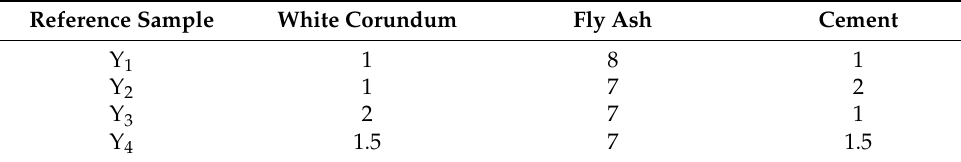
Table 2. Raw material ratios of reference samples.